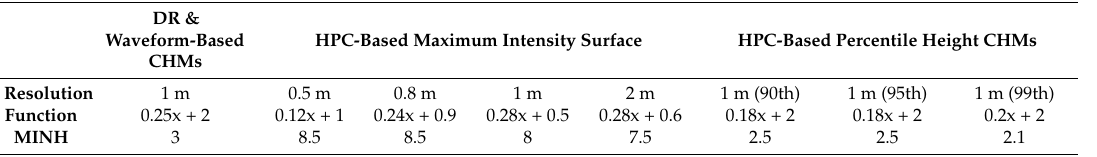
Table 1. Key parameters for tree crown segmentation using the LiDAR derived CHMs, the HPC-based MAXI surface and percentile height CHMs